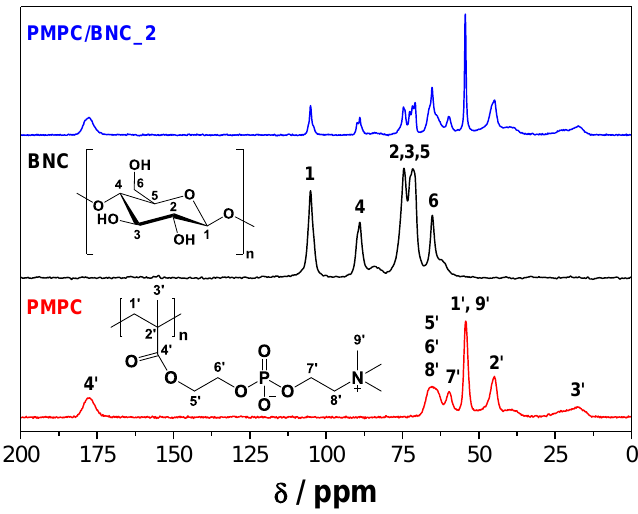
Figure3. 13 CCP / MASNMRspectraofcross-linkedPMPC,neatBNCandnanocompositePMPC / BNC_2. Figure 3. 13 C CP/MAS NMR spectra of cross-linked PMPC, neat BNC and nanocomposite PMPC/BNC_2.